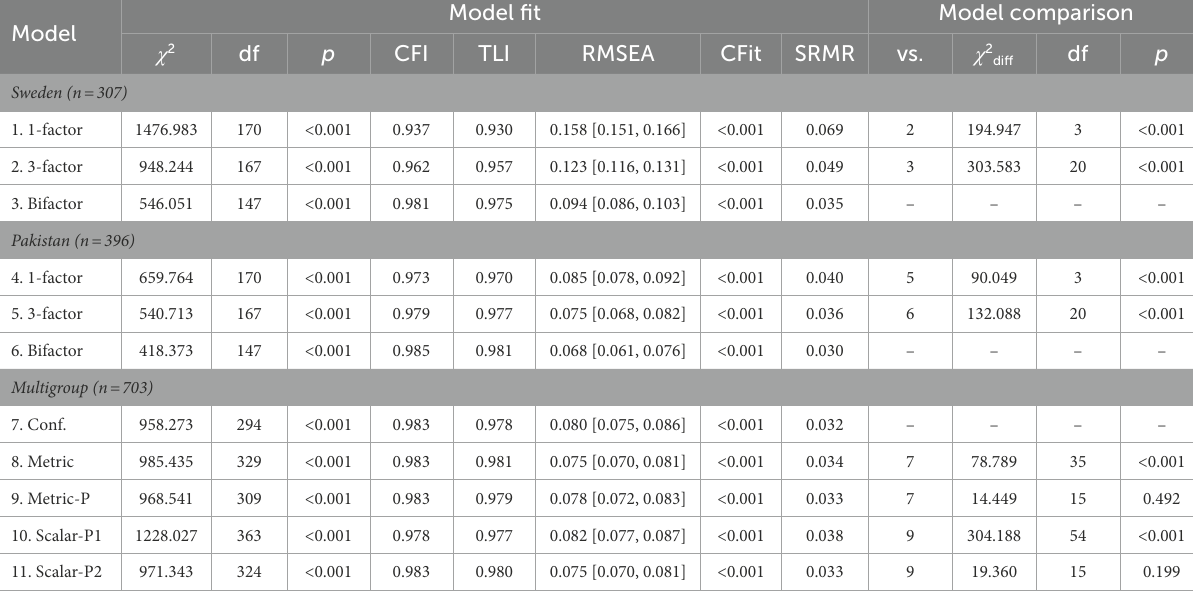
TABLE 1 Model fit and model